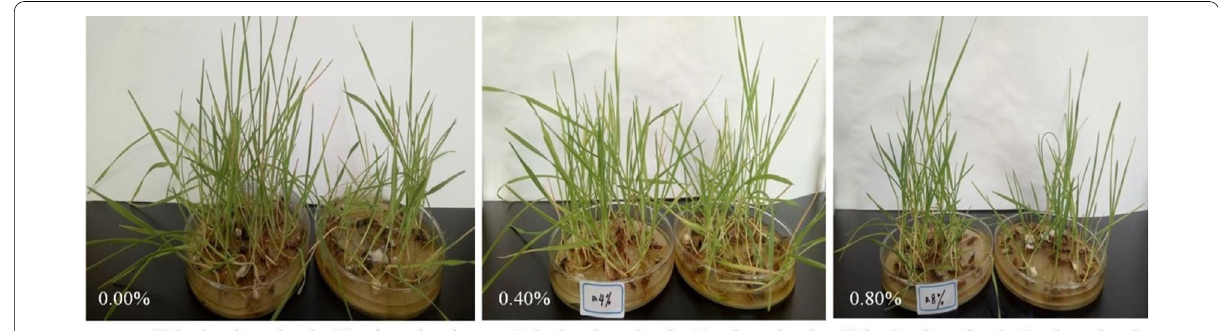
Fig. 1 Typical phenotype of L. multiflorum Lam. seedlings 2 weeks after inoculation or non-inoculation with X. badius under different NaCl-induced salt